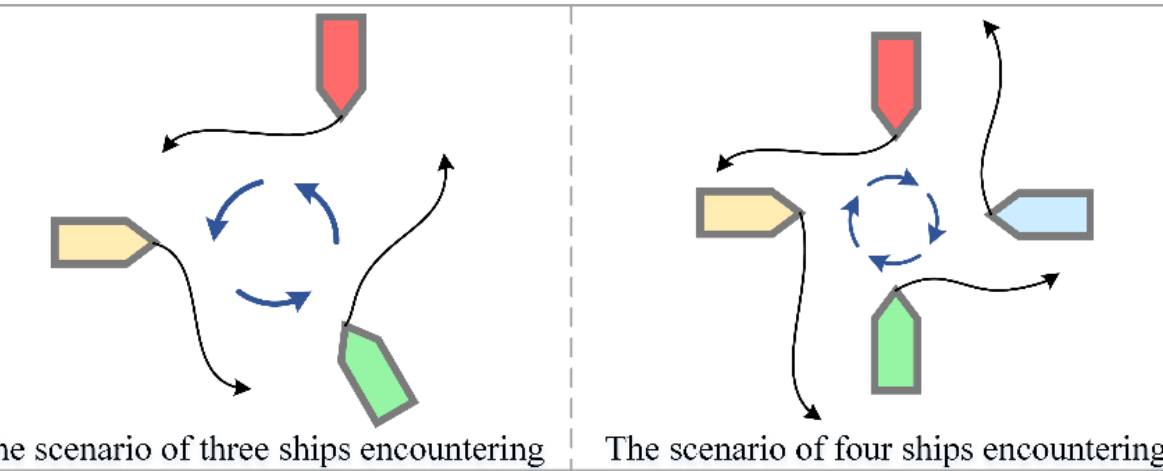
Figure 6. Multi-ship collision avoidance